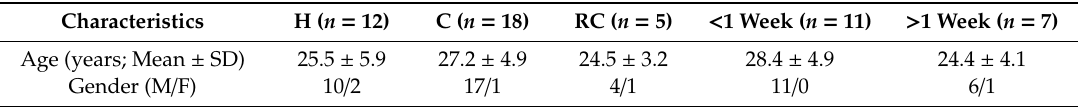
Table 2. Patient demographics. H = healthy controls, C = Single concussion, RC = repetitively concussed, < 1 week = athletes with a single concussion analyzed less than one week from injury, > 1 week = athletes with a single concussion analyzed more than one week from injury.